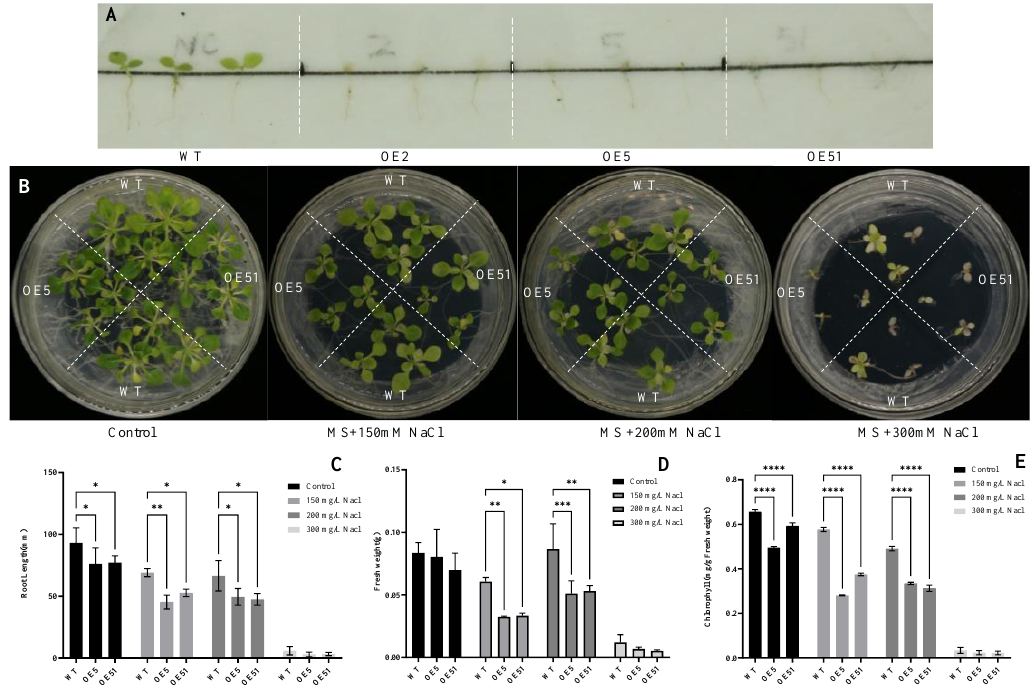
Figure 8. Determination of salt tolerance of HyPRP1 -overexpressing (OE) tobacco plants. ( A ) Salt resistance testing of HyPRP1 OE tobacco seedlings treated by 200 mM NaCl. HyPRP1 OE T 1 seedlings after kanamycin selection shifted to the filter with MS by adding 200 mM NaCl for treatment. ( B ) Phenotype of WT and HyPRP1 OE tobacco seedlings treated by 150, 200, and 300 mM NaCl. Uniformed transgenic T 2 seedlings were selected and shifted to MS media by adding 150, 200, and 300 mM NaCl for treatment respectively. Changes in root length ( C ), fresh weight ( D ) and chlorophyll content ( E ) in response to salt stress in WT and HyPRP1 OE tobacco seedlings. Values are means ± SE ( n = 3). The difference between OE or Ri compared to WT indicated * p < 0.05, ** p < 0.01, *** p < 0.001, *** p < 0.0001..